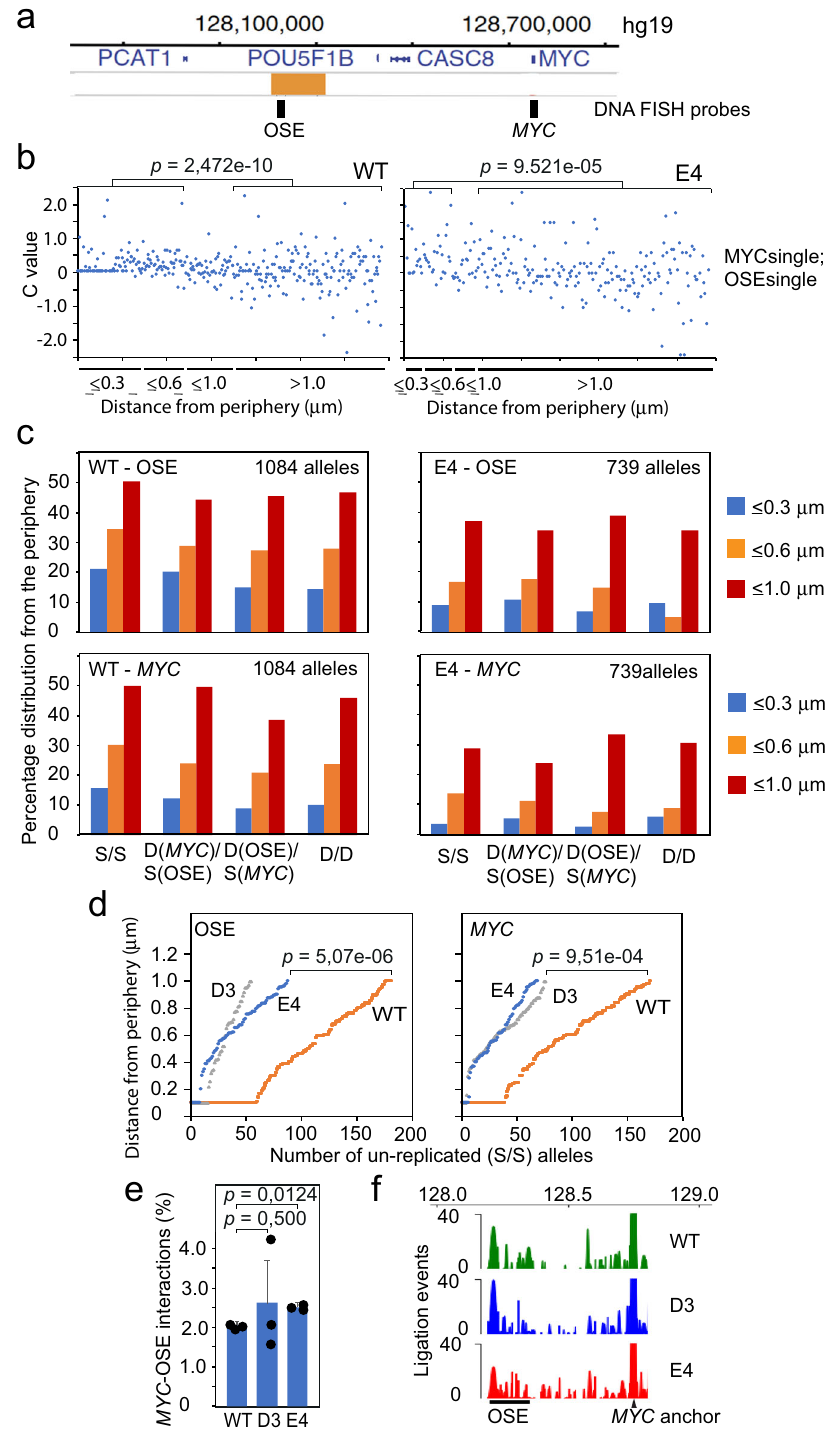
observations that the OSE and MYC regions are most proximal to each other when positioned within 0.5 μ m from the periphery 7 (Fig. 5a, b) — a sub-compartment with declining CCAT1 eRNA transcription (Fig. 6b, c). Importantly, CCAT1 alleles displaying little or no transcriptional activity were more distal to the nuclear periphery (marked in red, Fig. 6c) than alleles displaying higher transcription (marked in blue, Fig.